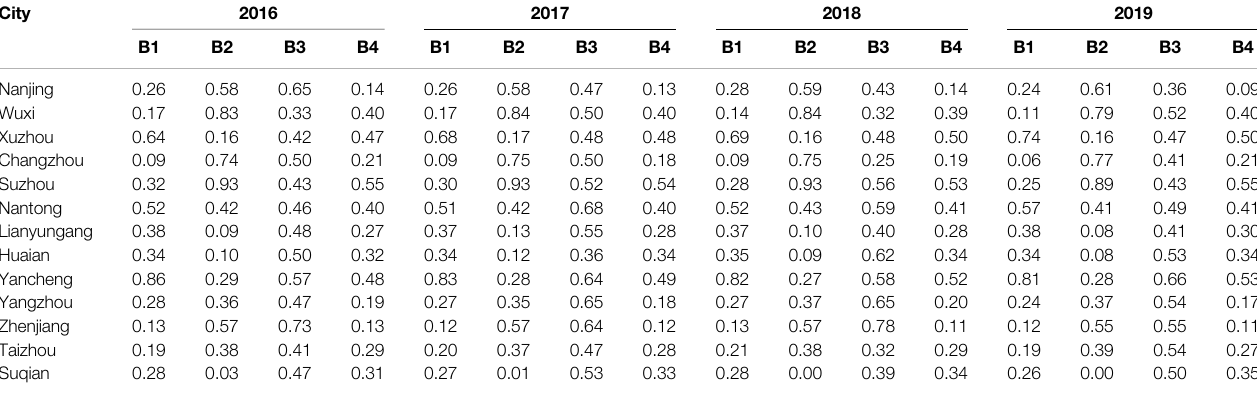
TABLE 2 | First-level indexes of SADL in cities in jiangsu province from 2016 to 2019. City